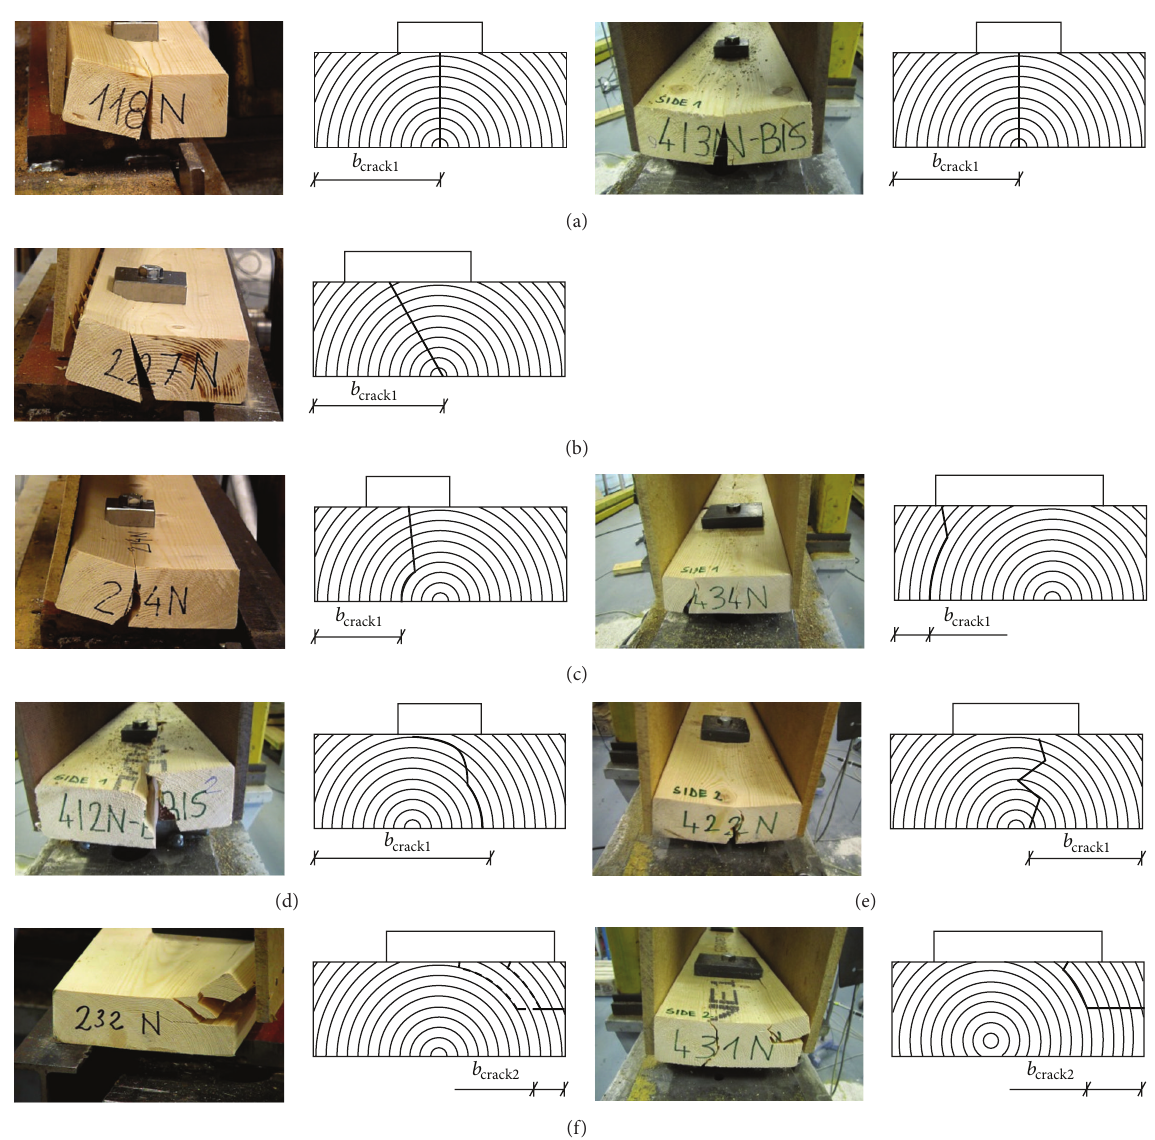
Figure 4: Crack development for bottom rail with pith oriented downwards (PD). (a) Mode 1 crack developing in a straight line starting and propagating vertically at the centre of the bottom rail; (b) mode 1 crack developing in an oblique line starting at a location close to the pith and propagating towards the loaded edge of the bottom rail; (c) mode 1 crack first following the annual rings and then propagating in a straight line towards the line of the anchor bolts; (d) mode 1 crack initiating off the centre on the bottom surface of the bottom rail and following an annual ring for a certain length and then jumping to another annual ring and propagating towards the centre of the upper surface of the bottom rail; (e) mode 1 crack propagating in an unusual “zig-zag” line across the annual rings; (f) mode 2 crack development, starting horizontally and then propagating vertically following the annual